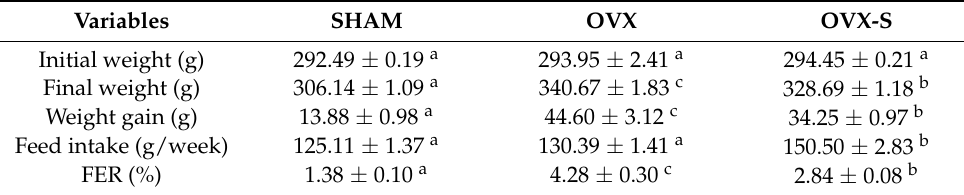
Table 2. Changes in body weight gain and feed efficiency of Superjami rice bran extract supplemen- tation diet in ovariectomized